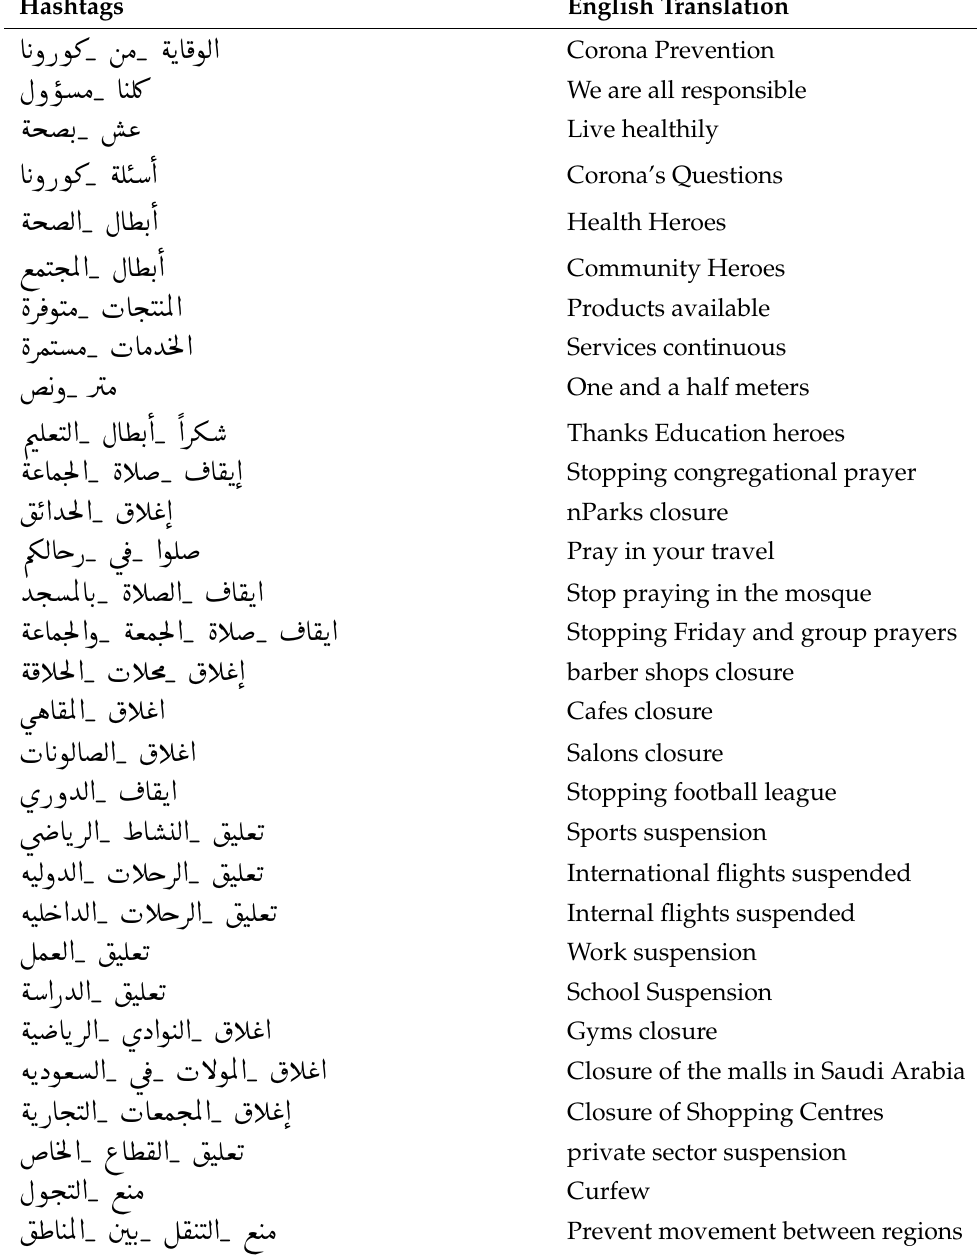
Table A1. Lists of popular hashtags used by the public in Saudi Arabia along with English translation.